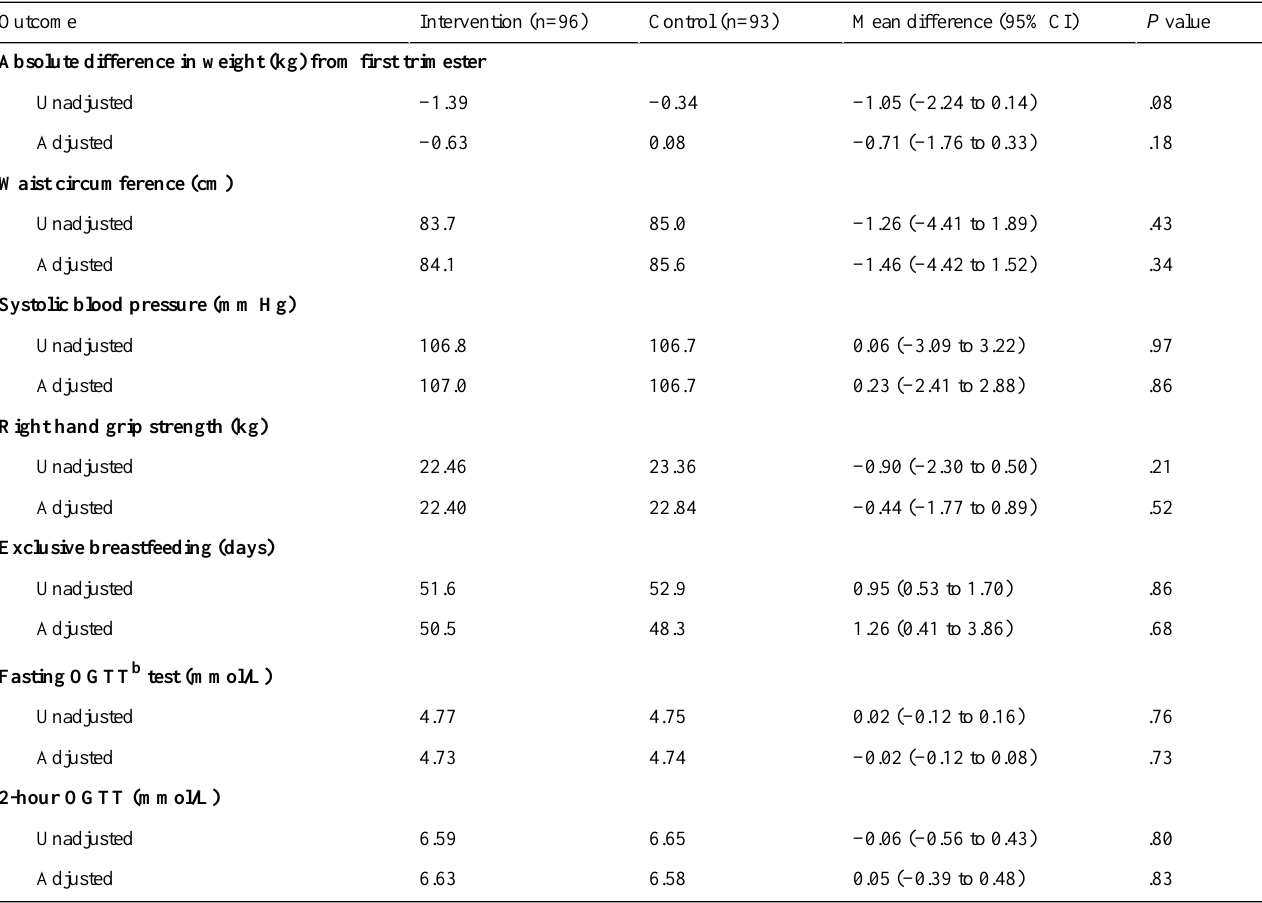
a Adjusted analysis is based on a linear mixed effect model adjusting for the respective baseline covariate (in addition, ethnicity and parity were also included for exclusive breastfeeding) and the effect of time, taking into account possible intrasubject correlation between the repeated outcomes at